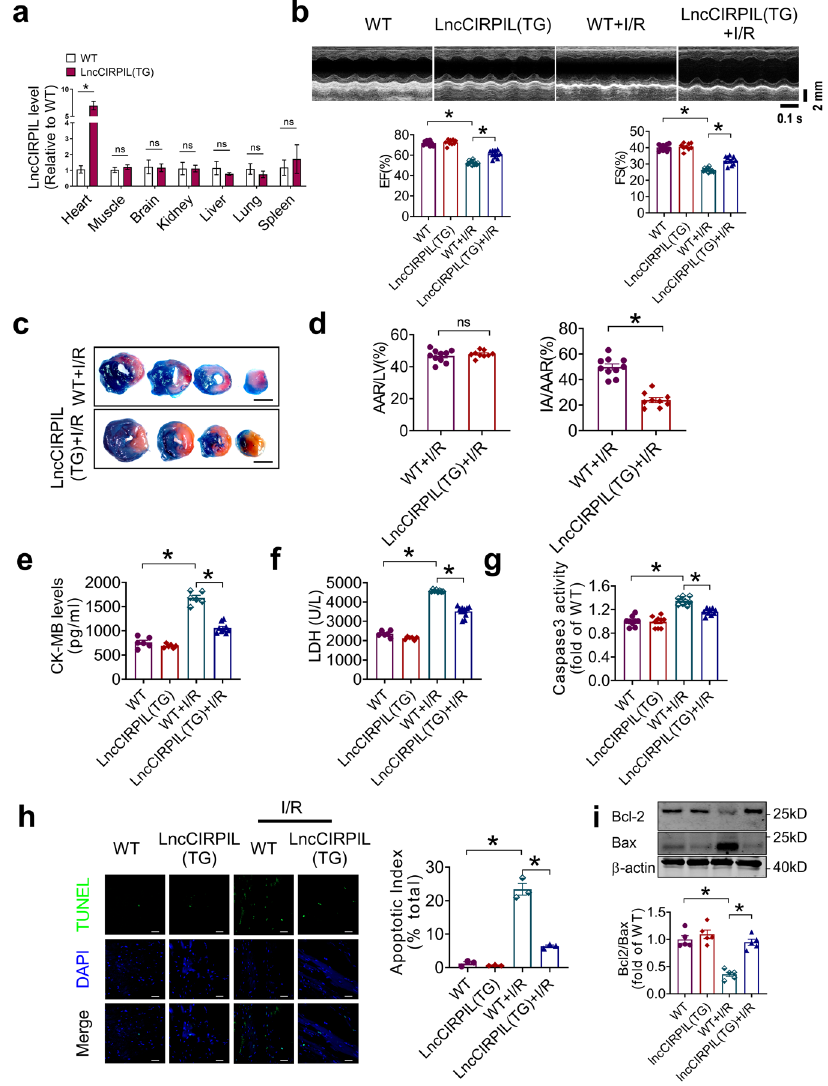
Fig. 3 Cardiomyocyte-speci fi c overexpression of lncCIRPIL protects the heart from ischemia/reperfusion (I/R) injury in mice. a LncCIRPIL expression in major organs of WT and lncCIRPIL-TG mice. n = 3. * P < 0.05 vs WT by two-tailed Student ’ s t test. b Representative cardiac echocardiography